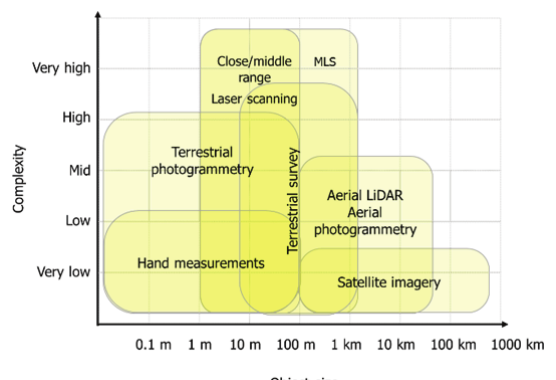
Figure 3. Three dimensional survey techniques characterised by complexity and object size (adapted from Böhler et al.,